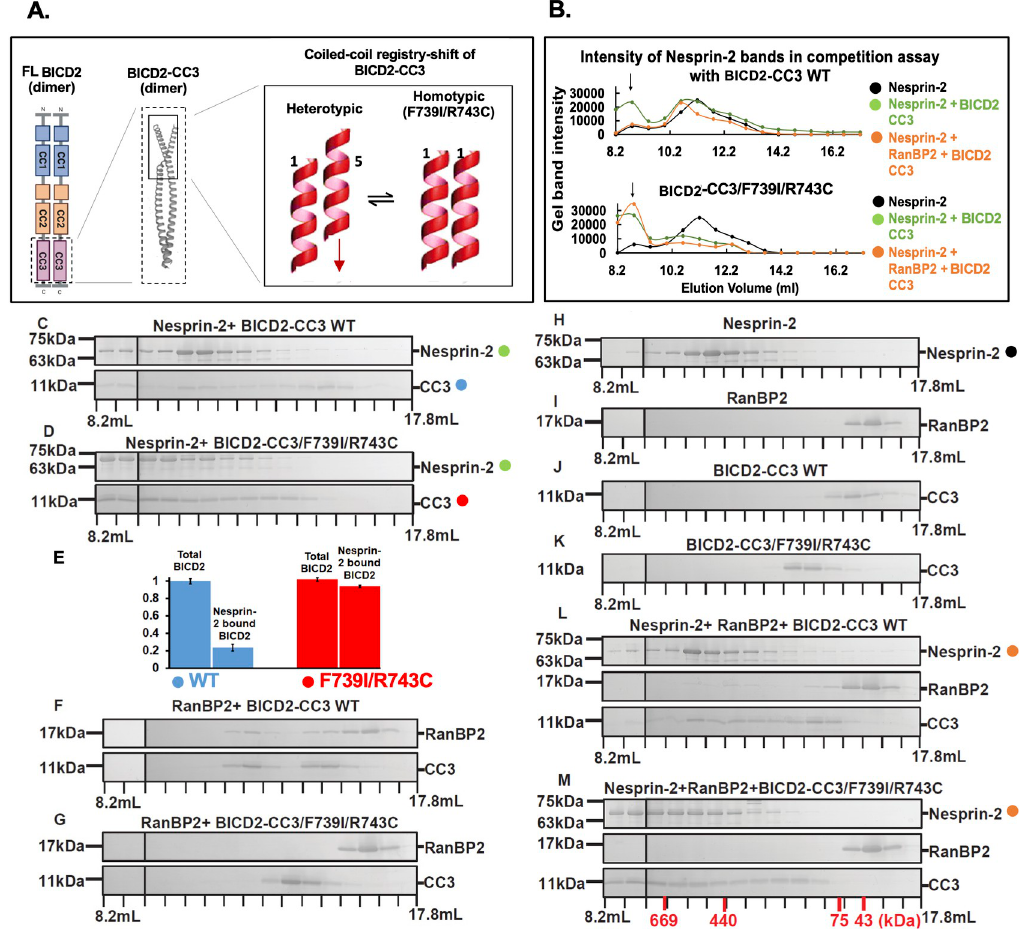
Fig 6. The registry-shift locked mutant F739I/R743C, preferentially binds to Nesprin-2. (A) Schematic depiction of the BICD2 dimer (left). CC3 is highlighted by a dashed box. The X-ray structure of human BICD2-CC3 in cartoon representation (middle; PDB ID 6OFP) is shown in the middle. The N-terminal half of the BICD2-CC3 dimer is highlighted by a box that is enlarged in the right panel. This region of BICD2 is likely undergoing a coiled-coil registry-shift from heterotypic to homotypic, which is depicted in a schematic manner. In the heterotypic registry, the two chains of the dimer are vertically displaced against each other by approximately one helical turn. In the homotypic coiled-coil registry, the chains are aligned at equal height [19]. (C,D and E-M) Purified Nesprin-2 fragment, RanBP2 fragment, and BICD2-CC3 were mixed in a 1:1:2 molar ratio (Nesprin-2: RanBP2: BICD2-CC3) and analyzed by size exclusion chromatography. SDS-PAGE analysis of the elution fractions and (B) intensity profiles of the gel bands are shown. (B) Intensity profiles of Nesprin-2 gel bands from the SDS-PAGEs shown in panels C, D, H, L and M (see color-coded circles). The Nesprin-2 elution peaks from the size exclusion chromatography assays with Nesprin-2, Nesprin-2 + BICD2-CC3 and Nesprin-2 + RanBP2 + BICD2-CC3 are compared for WT (top panel) and F739I/ R743C mutant (bottom panel) BICD2-CC3. The arrows point to complex formation, indicated by a shift of the elution peak towards higher mass. (C-L) SDS-PAGE analyses of elution fractions are shown. Masses of molecular weight standards are shown on the left and elution volumes on the bottom. (C) Nesprin-2 + BICD2-CC3 WT. (D) Nesprin-2 + BICD2-CC3/F739I/ R743C mutant. (E) The assays from (C, D) were repeated three times and each analyzed on a single SDS-PAGE together with 2 μ g of WT BICD2 (see S6 Fig) in order to quantify the amounts of BICD2-CC3 WT (blue) and F739I/R743C (red) in the gel bands. The amounts were normalized to 1 for total BICD2. Total BICD2 (i.e. BICD2 in all fractions) is shown versus Nesprin- 2-bound BICD2 (i.e. the BICD2 in the first nine fractions that co-elute with Nesprin-2 in S6 Fig). The error was calculated as standard deviation. (F) RanBP2 + BICD2-CC3 WT. (G) RanBP2 + BICD2-CC3 F739I/R743C. As controls, the individual proteins were also analyzed: (H) Nesprin-2 (I) RanBP2 (J) BICD2-CC3 (K) BICD2 CC3/F739I/R743C mutant. (L) Nesprin-2 + RanBP2 + BICD2-CC3 WT. (M) Nesprin-2 + RanBP2 + BICD2-CC3/F739I/R743C mutant. All experiments were repeated two times. The elution volumes of molar mass standards are indicated in red at the bottom of panel